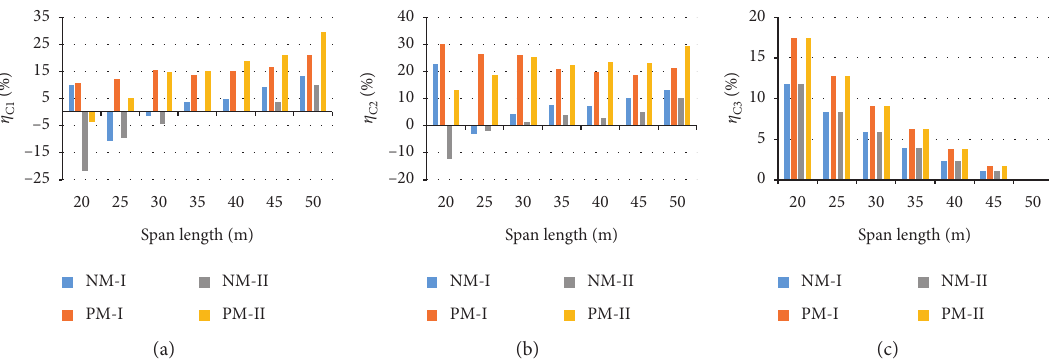
Figure 12: Comparison of the traffic loading effects of five-span continuous girder bridges without the dynamic load allowance: (a) η η C2 ; (c) η C3 .